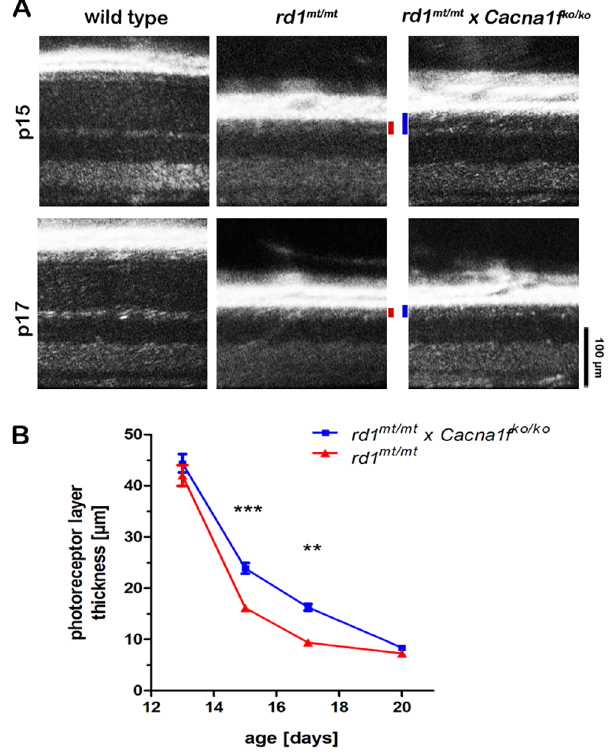
Fig 1. Knockout of Cacna1f delays photoreceptor cell loss in rd1 mt/mt mutant mice. (A) Representative in vivo OCT images of wild type, rd1 mt/mt and rd1 mt/mt x Cacna1f ko/ko retinas at p15 and p17. The vertical bars mark the corresponding outer nuclear layer (ONL) thickness. (B) Quantification of photoreceptor layer thickness (REC+) of the different genotypes at p13, p15, p17, and p20. Each data point represents the mean photoreceptor layer thickness (n = 8 per genotype and time point) ± SEM; ** p < 0.01, *** p < 0.001.